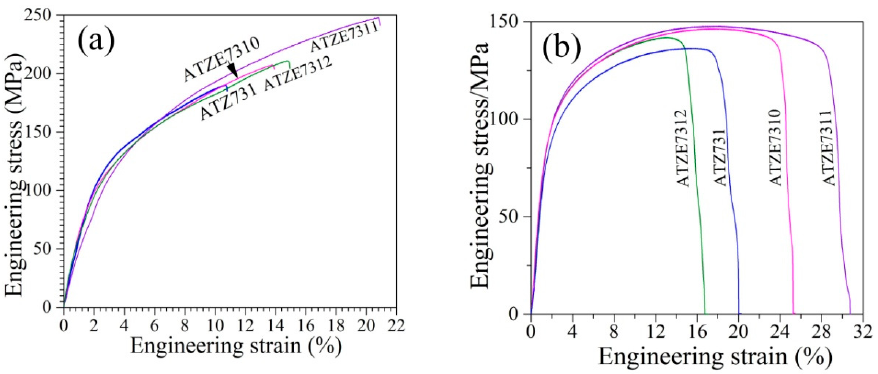
Figure 6. Engineering stress-strain curves of as-cast samples at ( a ) RT and ( b ) 175 ◦ C. Table 3. The average values of tensile properties of as-cast samples tested at RT and 175 ◦ C.